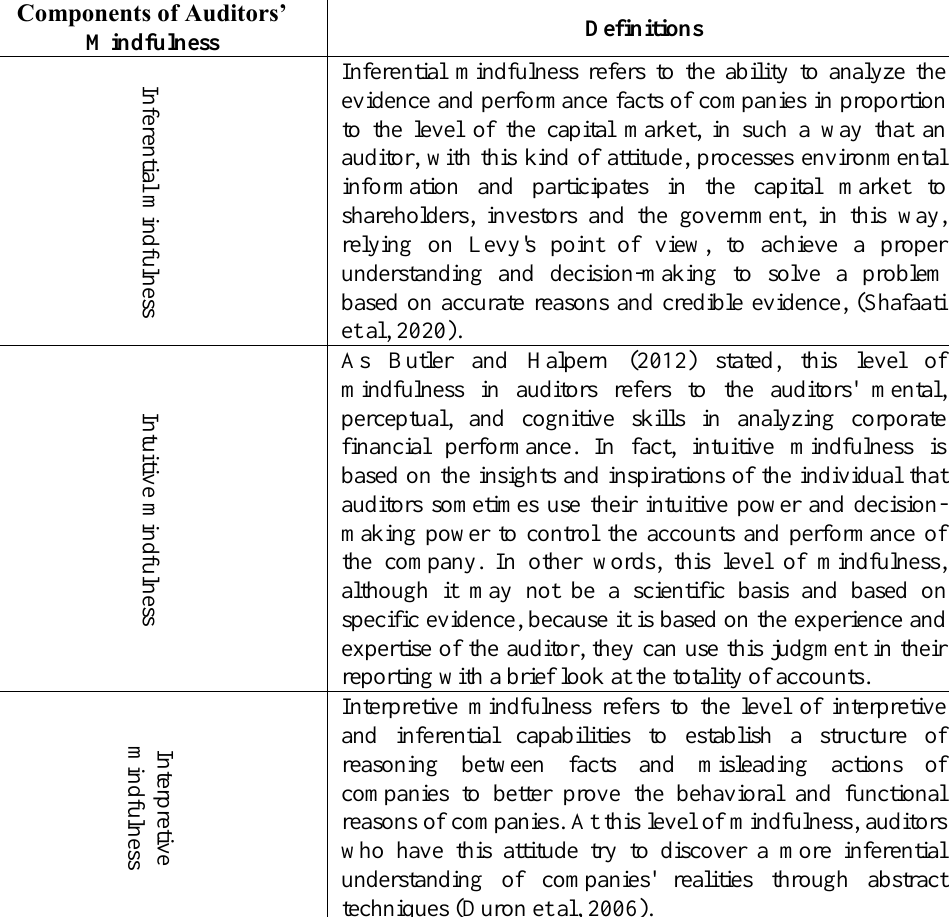
Table 6. Components of Auditors'